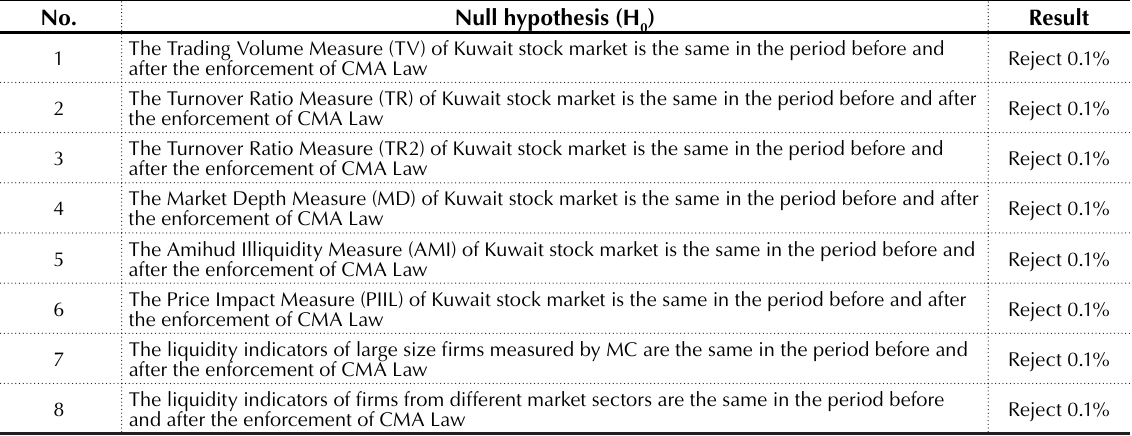
Table 8. Summary of hypotheses results testing of market liquidity in pre and post CMA Law period